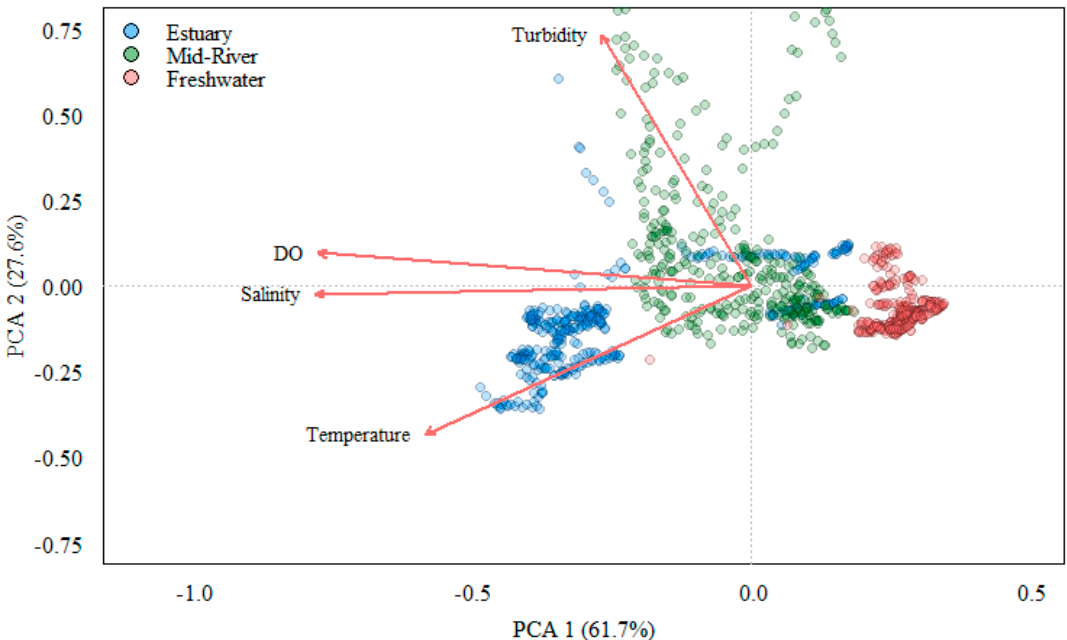
Figure 8. PCA biplot depicting the amount of correlation amongst water quality parameters salinity, DO, temperature, and turbidity during Hurricane Irma at the estuary ( blue ), freshwater 1 ( pink ), and middle reaches ( green ) sonde sites.